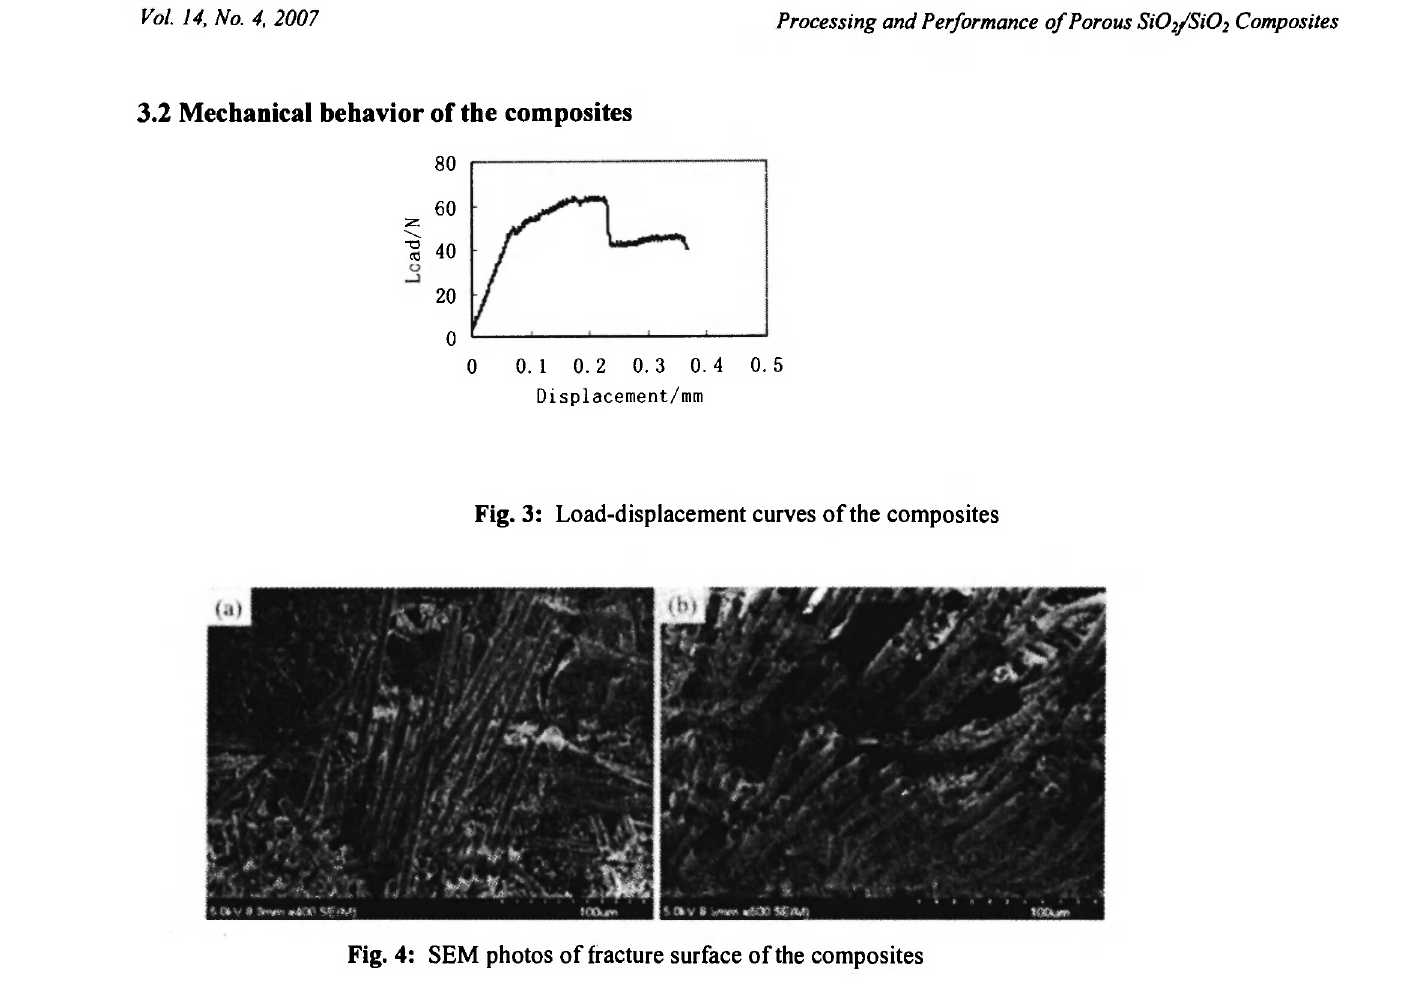
Fig. 4: SEM photos of fracture surface of the